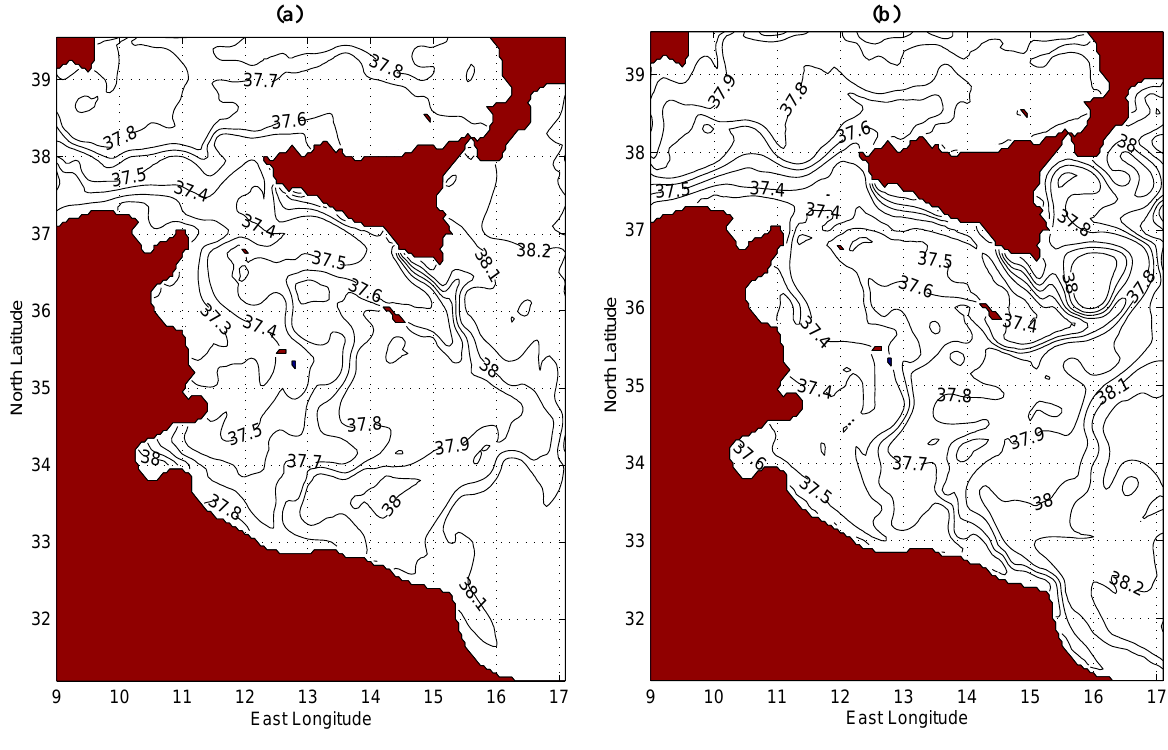
Fig. 12. The simulated 10-day averaged salinity field at 5m depth in (a) February and (b) August. The contour interval is